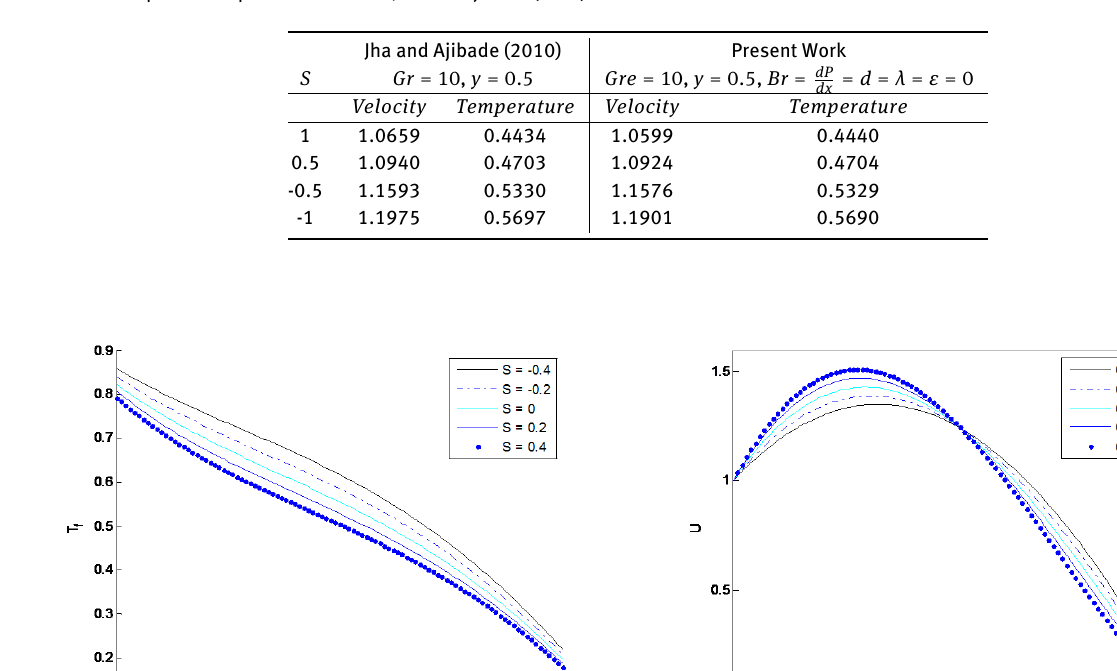
Table 5: Comparison of present work and Jha and Ajibade (2010)